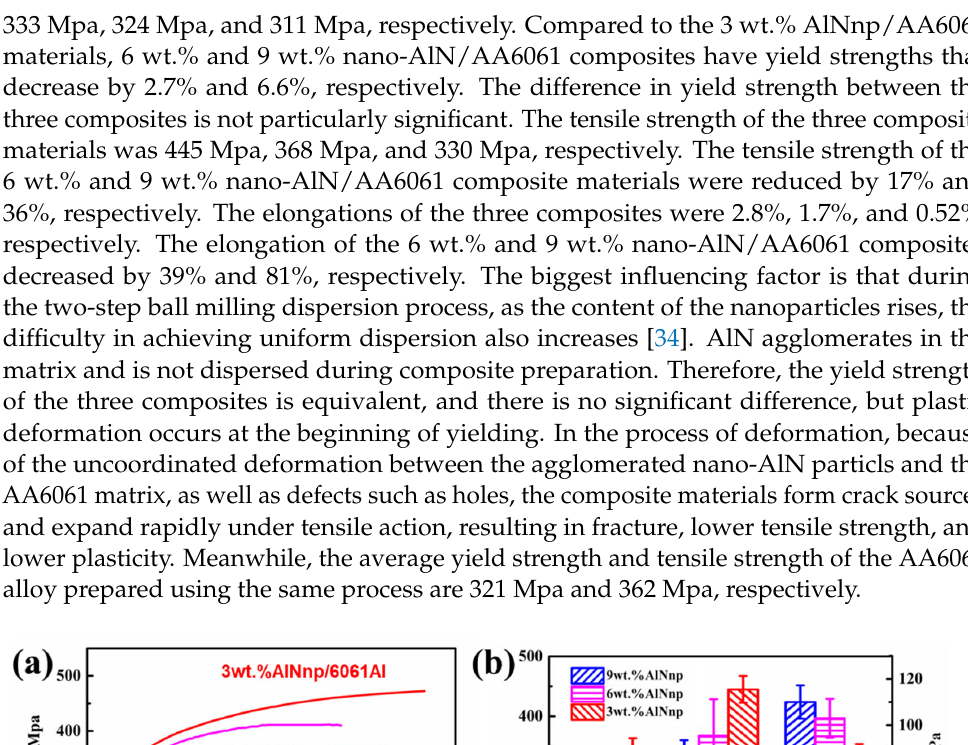
Figure 11. Fracture surface of nano ‐ AlN/Al composites: ( a , b ) As ‐ cast; ( c , d ) After HE. 3.4. Strengthening Mechanism of Nano ‐ AlN/AA6061